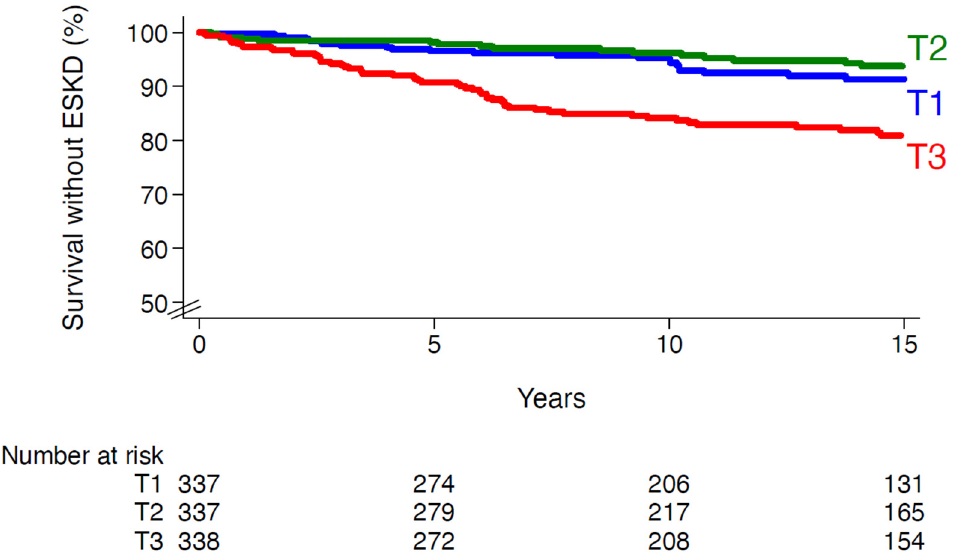
Figure 1. Survival without end-stage kidney disease according to tertiles of redox genetic risk score. T1, first tertile; T2, second tertile; T3, third tertile. Log-rank p -value < 0.0001. Table 2. Risks of ESKD during follow-up by tertiles of redox genetic risk score.